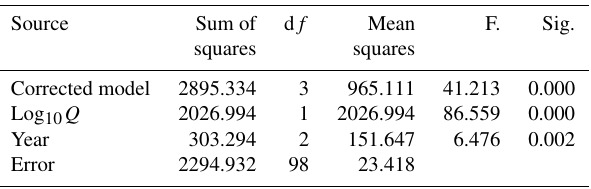
Table 2. Results of covariance analysis (ANCOVA) between dis- charge and the DOC concentrations for the 2012–2014 sampling